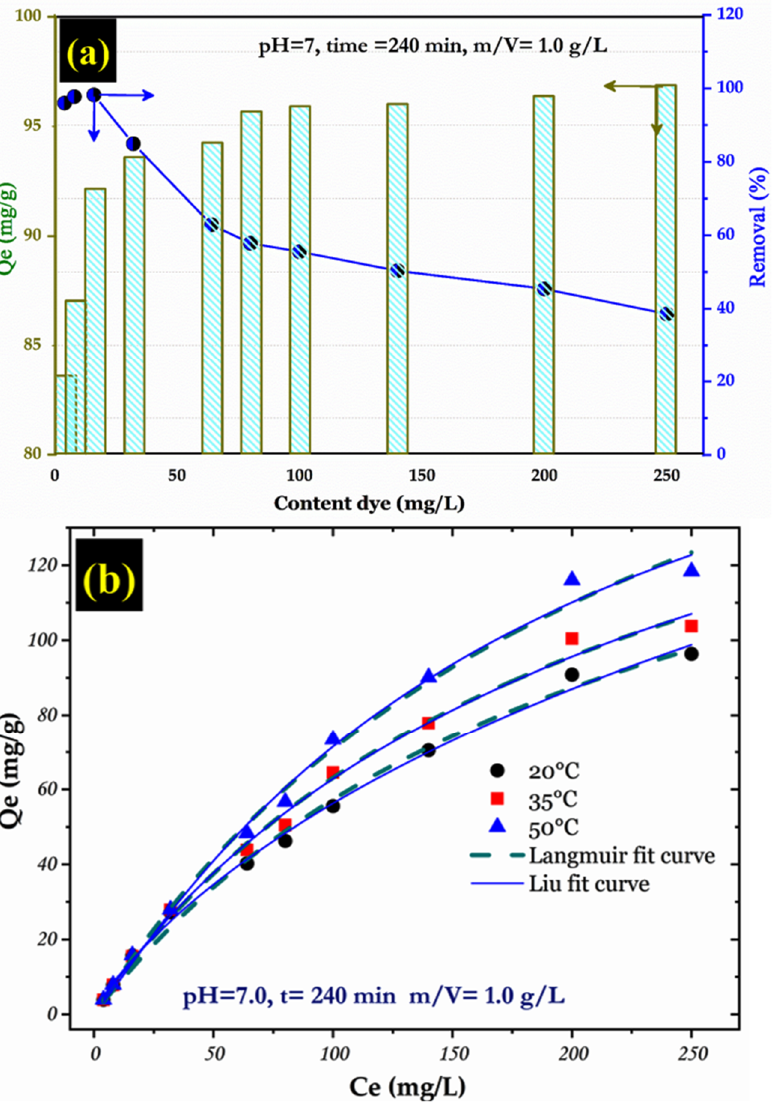
Figure 7. ( a ) Effect of initial CV dye concentration on percentage of elimination and adsorption capacity, and ( b ) and nonlinear relationship of Langmuir and Liu isotherm models.